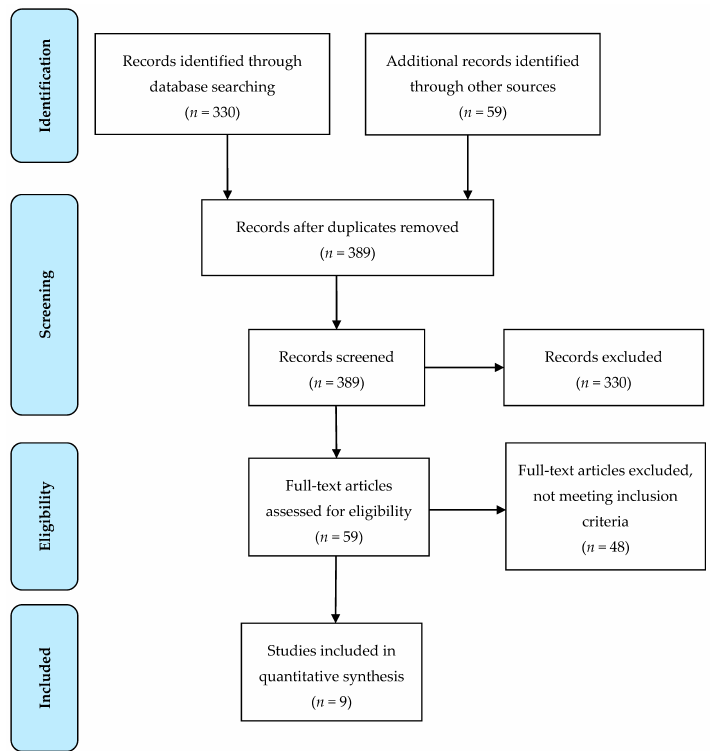
Figure 1. Flow chart of trial search for inclusion in review using PRISMA method.